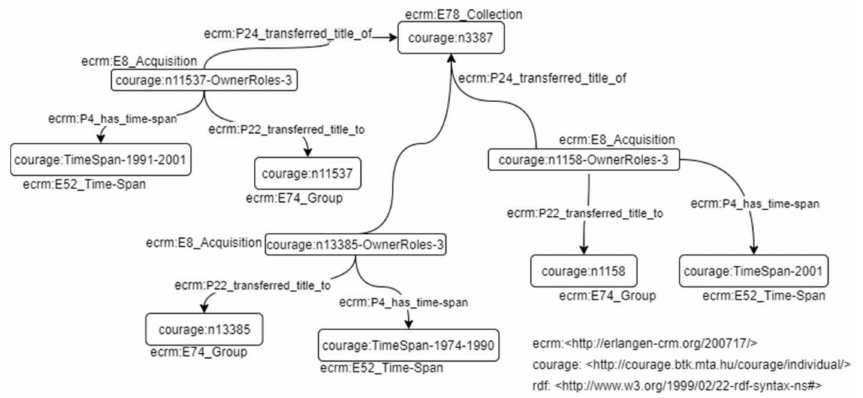
Figure 6. An example of owner role representation in CIDOC-CRM. The founder role, which refers to the founder of a collection in COURAGE, was represented in CIDOC-CRM using the E66 formation. Then we found that the purpose